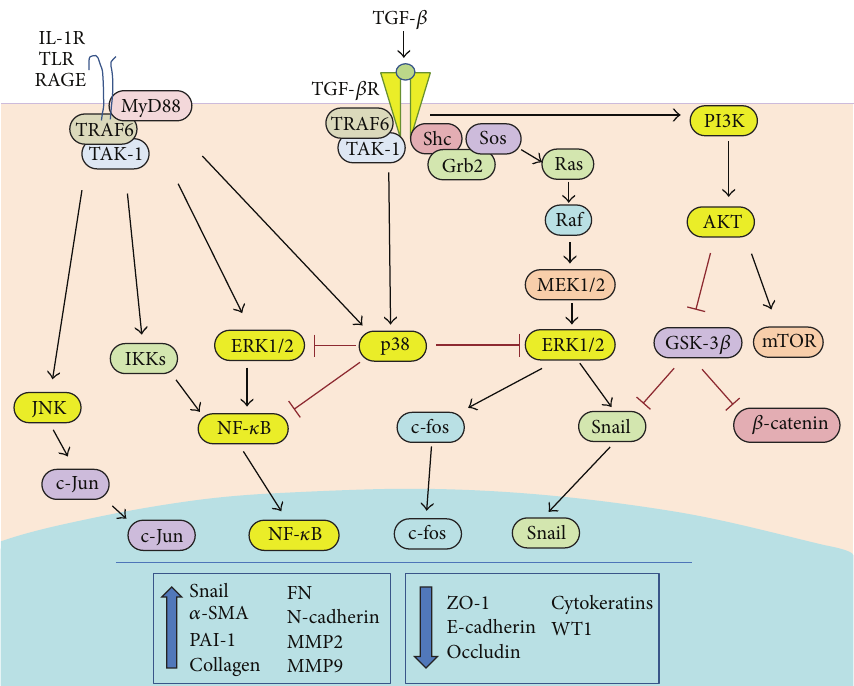
Figure 2: Cooperation between signals delivered by TGF- 𝛽 and Toll-like/IL-1 𝛽 receptors in the EMT of MCs. TGF- 𝛽 delivers pro-EMT signals inducing the Smad2/3 (not described in this figure) and the non-Smad pathways, composed of MEK/ERK1/2 and PI3K pathways. IL-1 𝛽 and TLR ligands activate redundant pathways leading to activation of NF- 𝜅 B and ERK1/2. Also, pathways able to limit EMT induction, such as p38, are induced at the same time. Smad2/3 acted as transcription factor in combination with Snail, NF- 𝜅 B, and AP-1 to induce the EMT